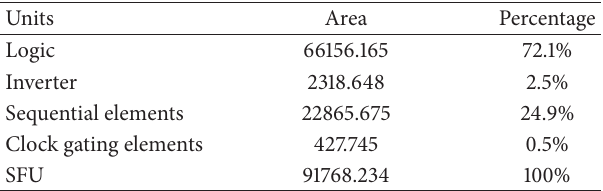
Table 7: Gate utilization report for each unit.